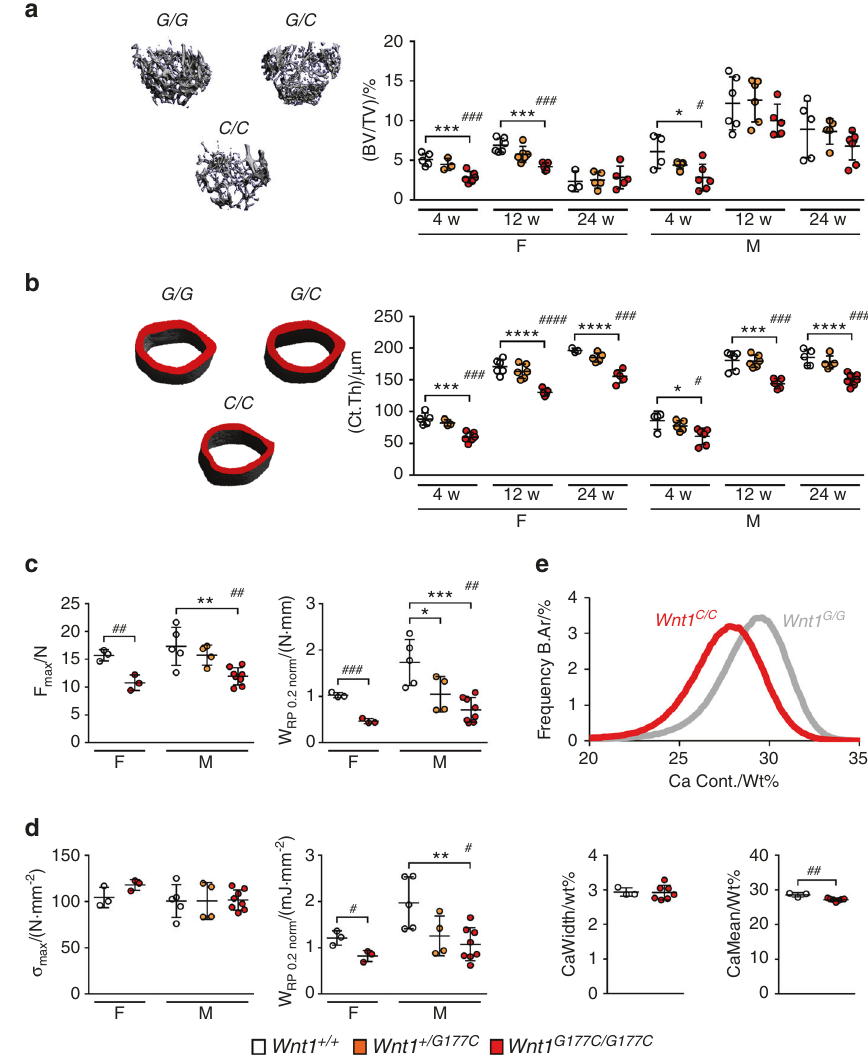
Fig. 4 The WNT1 G177C mutation primarily affects the quantity and quality of cortical bone. a Representative µCT images of the trabecular bone in the distal femoral metaphysis from 12-week-old female mice. Quanti fi cation of the trabecular bone volume in female and male Wnt1 + / + ( G/G ), Wnt1 + /G177C ( G/C ), and Wnt1 G177C/G177C ( C/C ) mice at 4, 12, and 24 weeks of age is given on the right. b Representative µCT images of the cortical bone in the central femoral diaphysis from 12-week-old female mice. Quanti fi cation of the cortical thickness in female and male Wnt1 + / + ( G/G ), Wnt1 + /G177C ( G/C ), and Wnt1 G177C/G177C ( C/C ) mice at 4, 12, and 24 weeks of age is given on the right. c Quanti fi cation of mechanical properties of the femora from 24-week-old female and male mice with the indicated genotypes as determined by 3-point bending (F max : Maximum force that the bone could withstand; W Rp0.2 : Work required to induce plastic deformation). d Quanti fi cation of the same parameters after normalization for morphological differences. e qBEI-based analysis of calcium distribution (top) and quanti fi cation of the calcium content (bottom) in the cortical compartment of tibiae from 24-week-old male wild-type and Wnt1 G177C/G177C mice. Data were analyzed by one-way ANOVA with Dunnett ’ s multiple comparison test (* P < 0.05, ** P < 0.01, *** P < 0.001, **** P < 0.000 1) and Student ’ s t